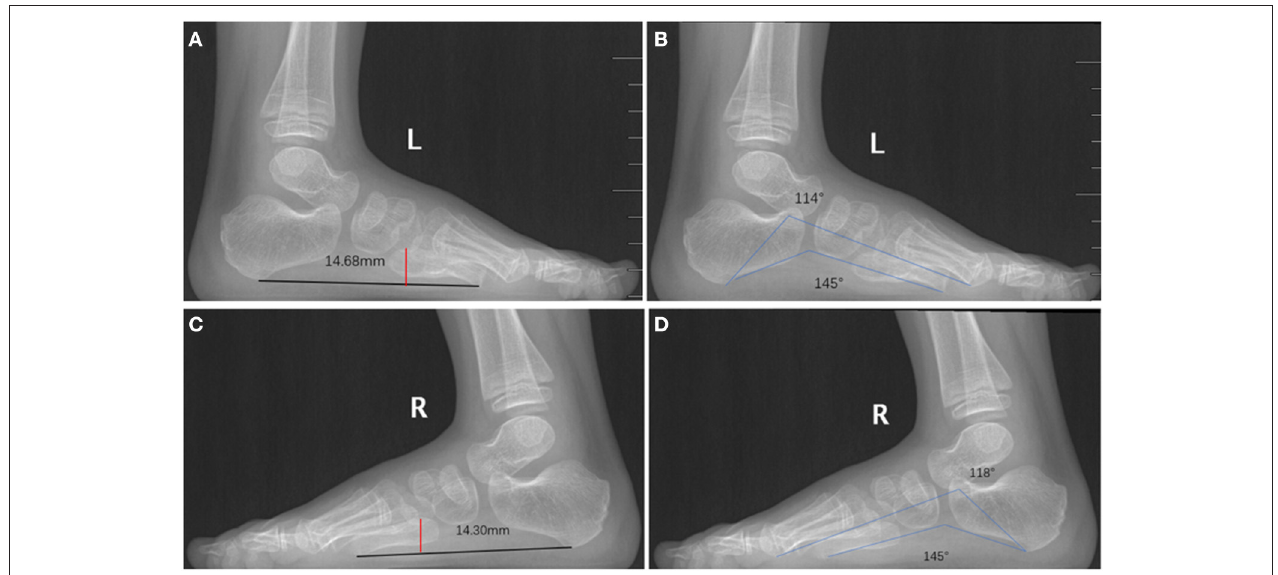
FIGURE 6 | Postoperative medial and lateral arches of feet. (A) The height of the fifth metatarsal bone of left foot was 14.68mm. (B) The medial arch of left foot was 114 ◦ and the lateral arch was 145 ◦ . (C) The height of the fifth metatarsal of right foot was 14.30mm. (D) The medial arch of right foot was 118 ◦ and the lateral arch was 145 ◦ . The reconstructed lateral arch is similar to the unimpaired